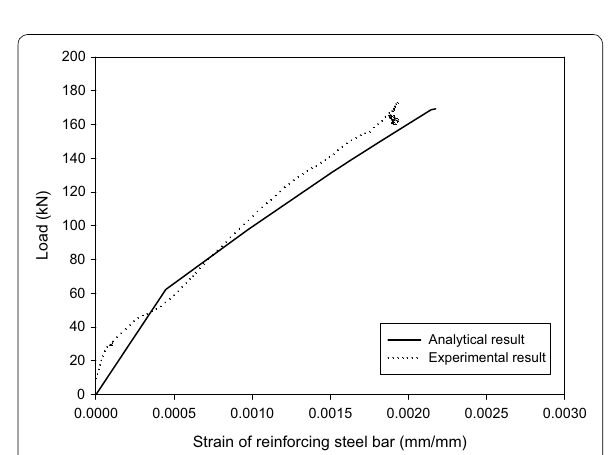
Fig. 9 Load-strain curves predicted from the FE models.